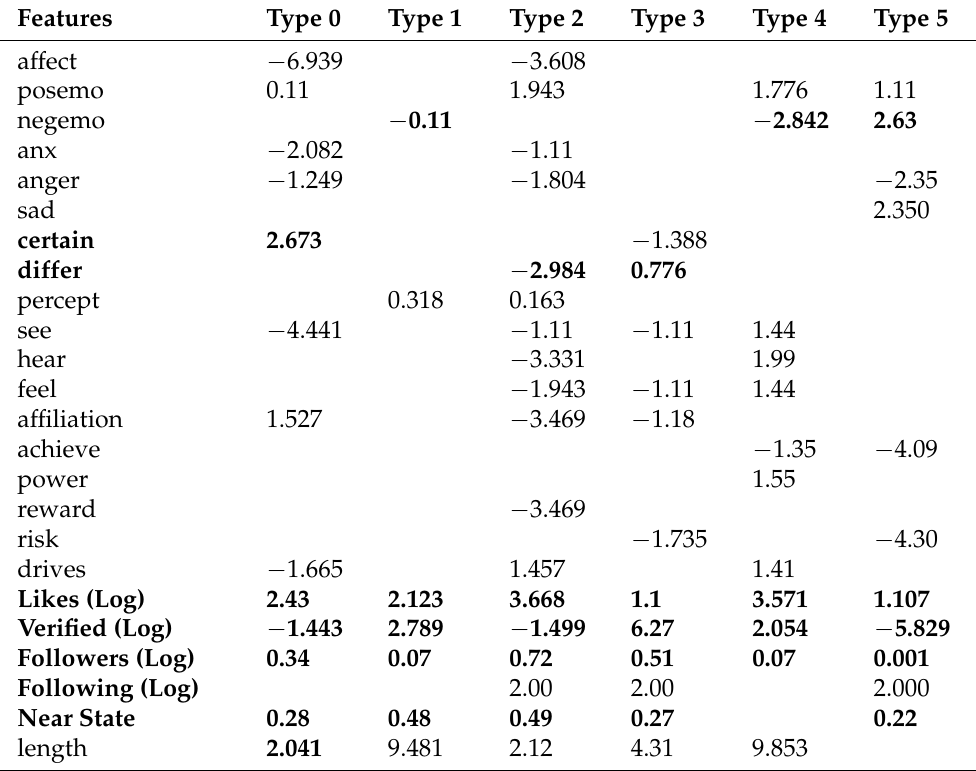
Table 6. Coefficients of all Features for the best Regression model of Each Type of Situational Information, and bold values in columns indicate the importance of the values and these values also indicate higher impact than other variables on the re-tweet